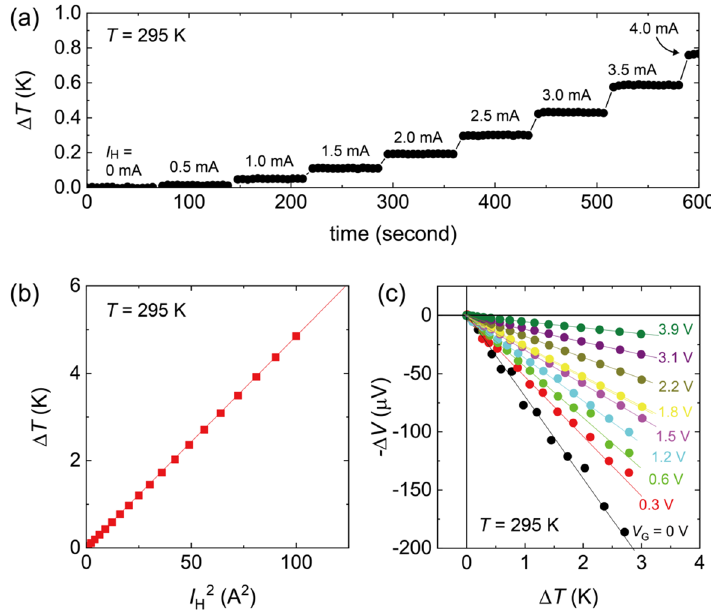
Figure 2. On-chip thermoelectric measurements of WO 3 thin film. ( a ) Temperature difference Δ T for different heater current I H . When I H was applied to the heater in Fig. 1a, Δ T was induced between the edges of the channel due to the Joule heating of the heater. The values of Δ T increased with increasing I H . ( b ) Heater power dependence of Δ T . The values of Δ T linearly increased against I H 2 , confirming that the temperature gradient on the sample is solely attributed to the Joule heating of the heater. ( c ) Thermoelectric voltage Δ V under Δ T in WO 3 thin film. The measurements were performed at 295 K. The slope of the Δ V − Δ T plot was systematically suppressed with increasing V G